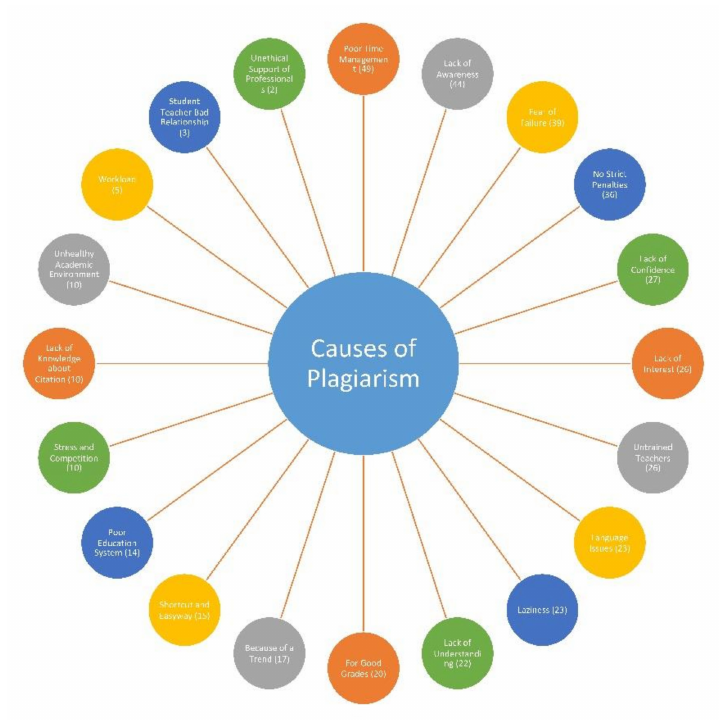
Figure 1. Determinants of